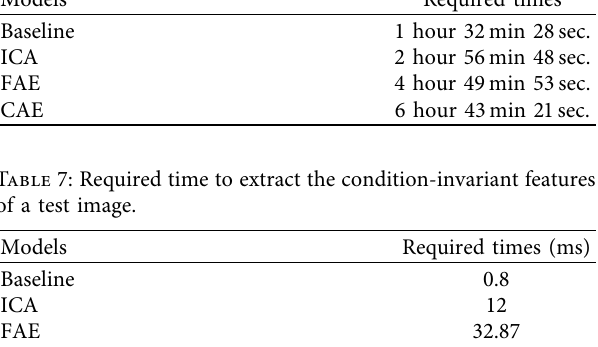
Table 6: Compilation times of the models. Models